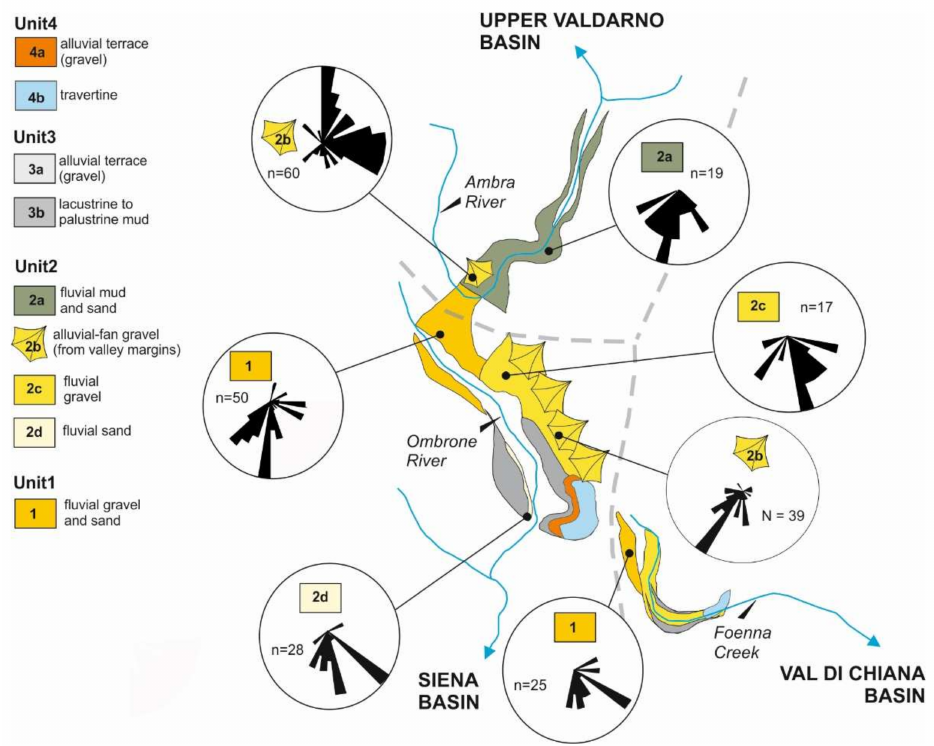
Figure 12. Paleocurrents distribution within the study deposits. Grey dashed line represents the watershed displayed in Figure